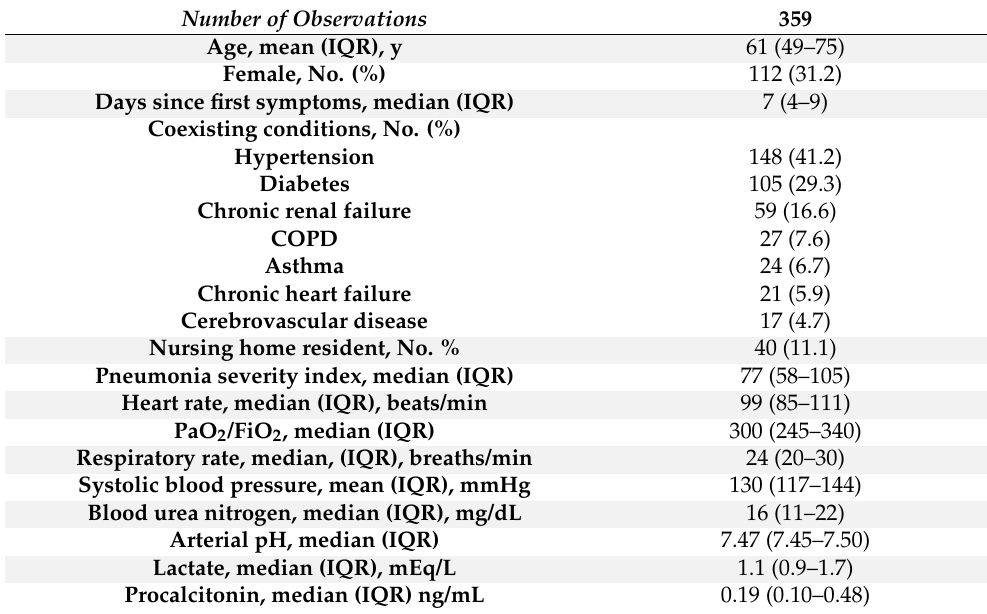
Table 1. Demographic and clinical characteristics at study inclusion.